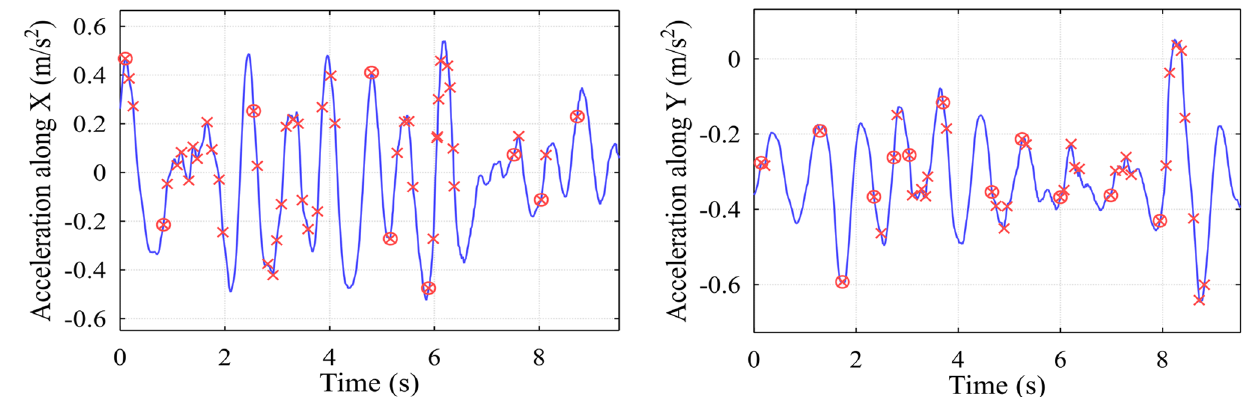
Figure 9. Detection results along the X and Y − axes using the IDM and the AE methods.